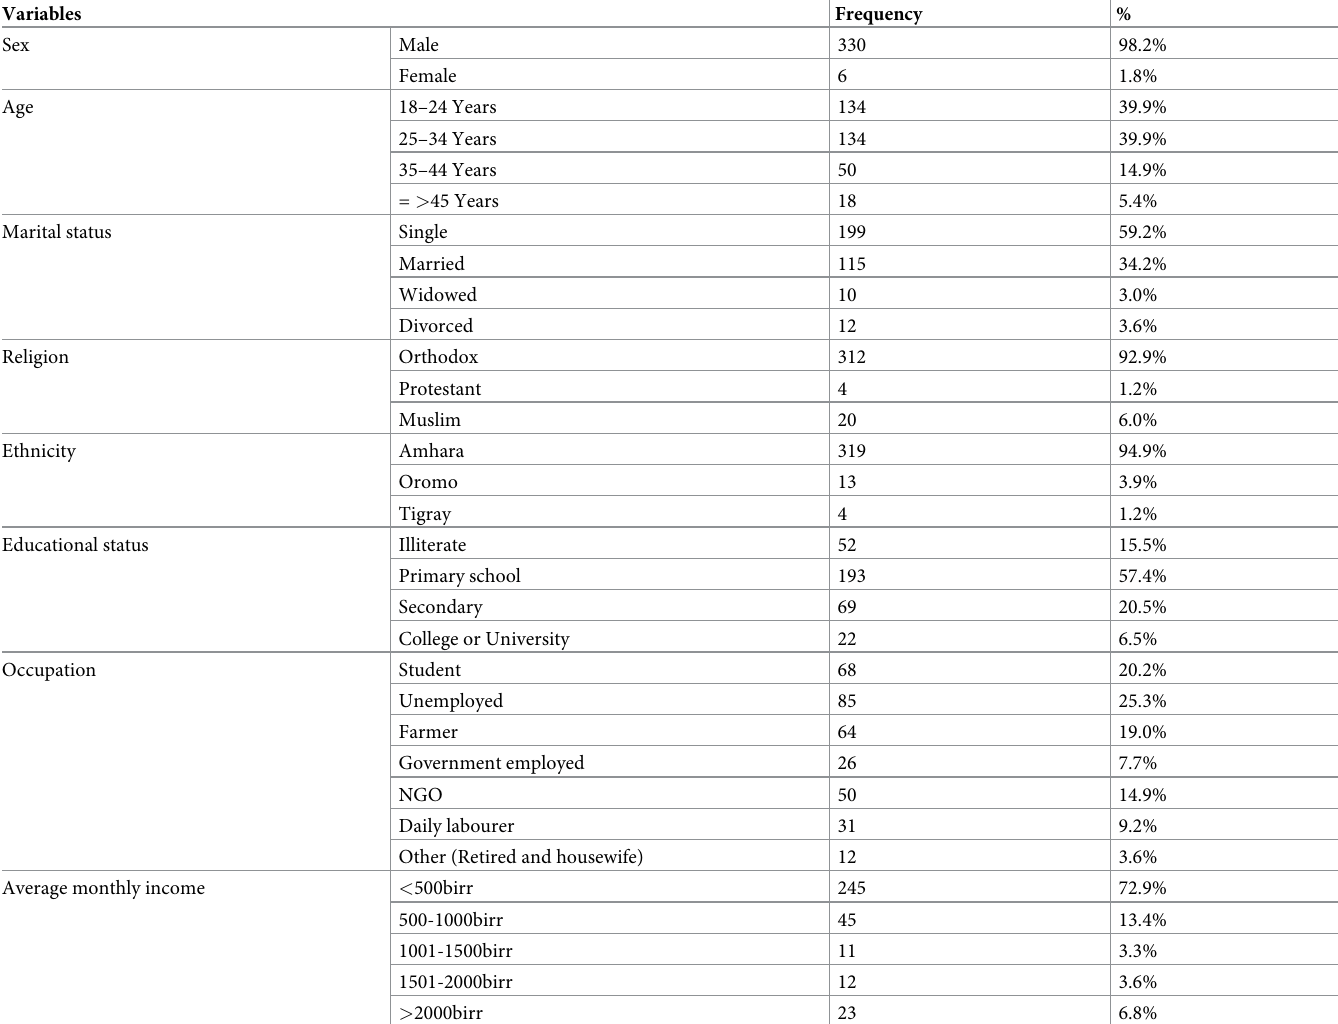
Table 1. Socio-demographic characteristics of inmates of Debre Berhan prison, Ethiopia,